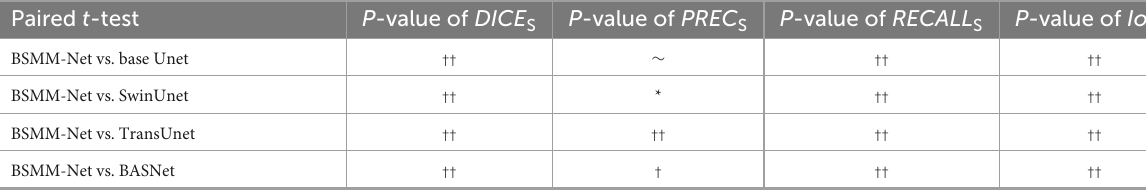
TABLE 3 The t -test results for the proposed method vs. the competing method. Paired t -test P -value of DICE